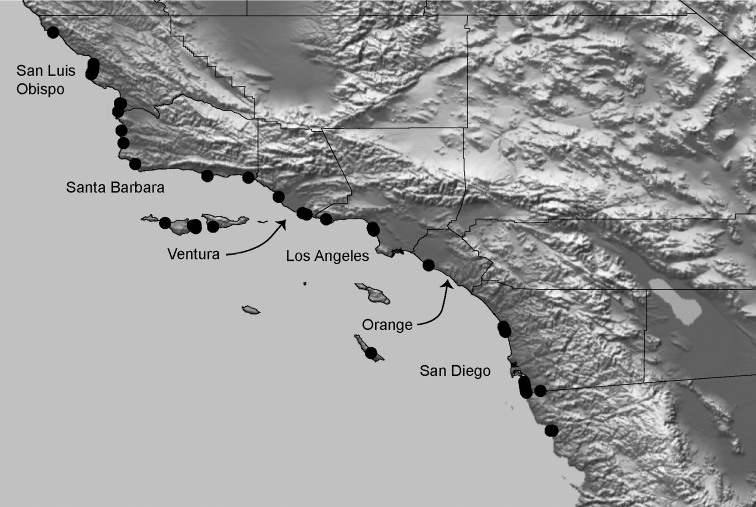
Known distribution of Aptostichus simus. Monterey County localities not shown.